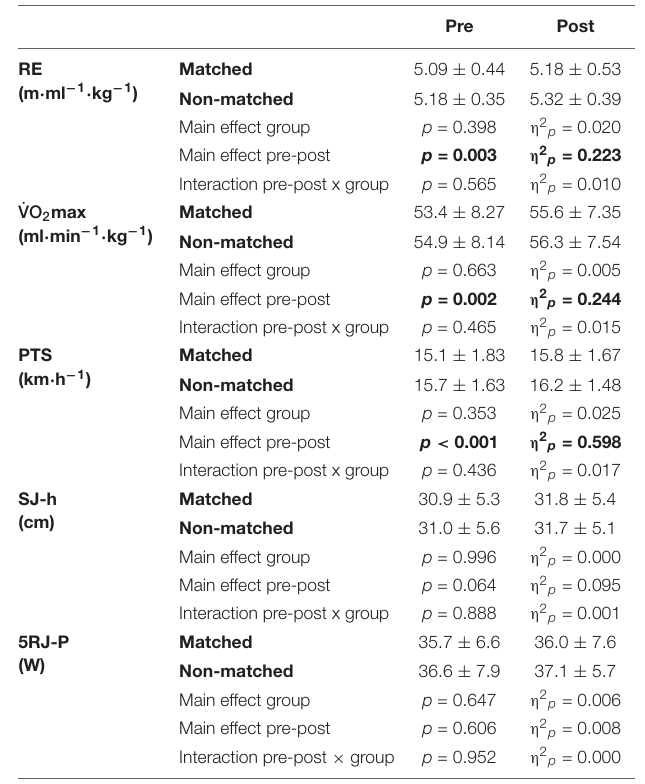
TABLE 3 | Mean ± SD for running economy (RE), maximal oxygen uptake ( ˙ VO 2 max), peak treadmill speed (PTS), squat jump height (SJ-h), and average mechanical power during the positive (concentric) work per body mass of five repeated rebound jumps (5RJ-P) per training group, pre and post the training intervention as well as main effects (pre-post and group) and interaction effect (pre-post × group) for these five performance related variables.